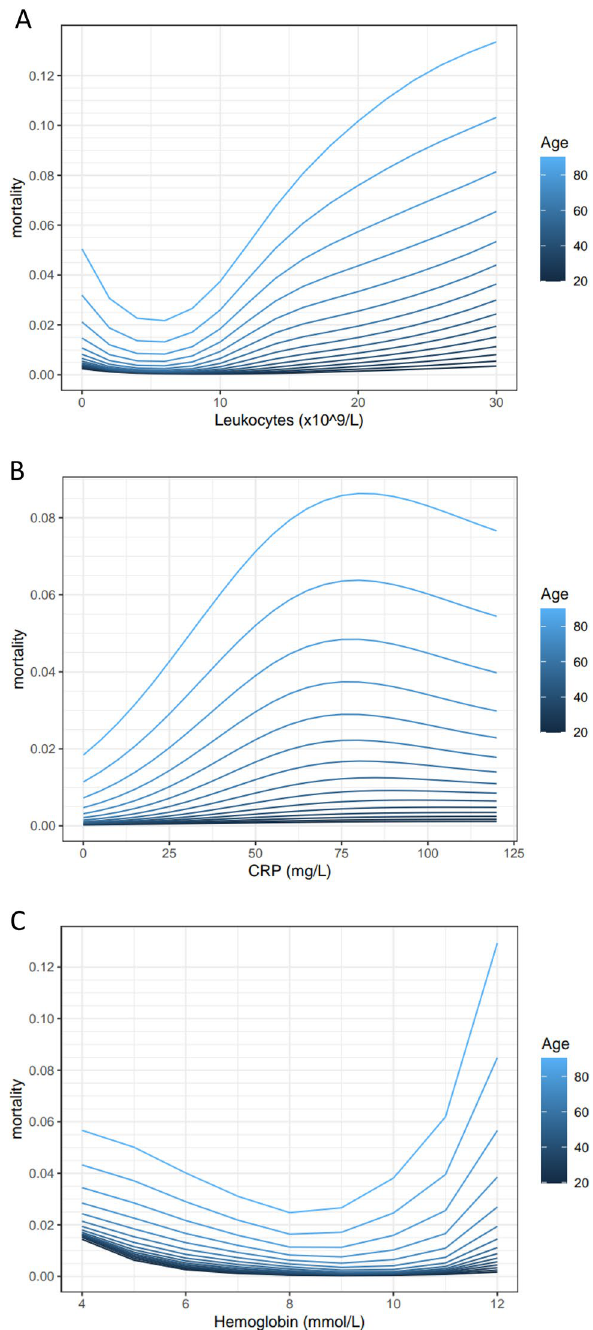
Figure 2. The associations between leukocytes ( A ), C-reactive Protein ( B ), hemoglobin ( C ) and mortality and age are shown using a generalized additive logistic regression model. This model included five biomarkers and age. The four biomarkers that are not shown in the panel were left constant at ‘normal’ values. These were chosen as follows: creatinine = 80 µmol/L, leukocytes = 8.0 × 10^9/L, CRP = 10 mg/L, Sodium = 140 mmol/L, and hemoglobin = 9 mmol/L. Mortality is shown as mean predicted mortality risk (between 0 and